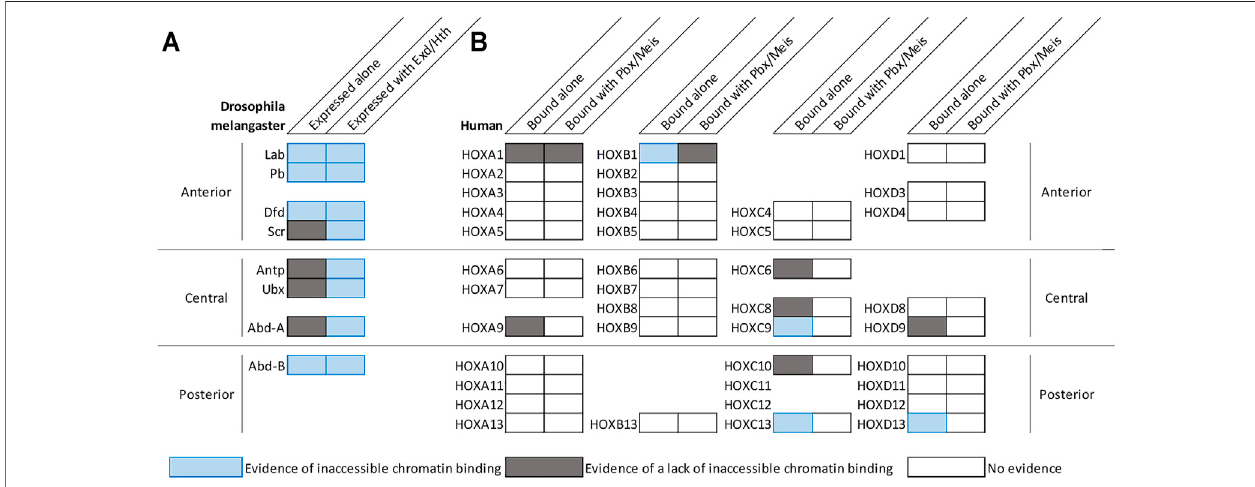
FIGURE 1 | Select Hox factors can bind inaccessible chromatin with and/or without the help of common co-factors. (A) Diagram summarizing the genomic DNA binding activities of Hox TFs in Drosophila Kc167 cells (data from Beh et al., 2016; Porcelli et al., 2019). By comparing the chromatin accessibility pro fi les of cells prior to Hox factor transfection and genome binding pro fi les after Hox factor transient transfection in Kc167 cells, Beh et al. and Porcelli et al. demonstrated that anterior factors andposterior Drosophila factorstendtohavetheabilitytobindinaccessiblechromatin(Behetal.,2016;Porcellietal.,2019).Furthermore,ExdandHthexpression tend to enhance a factor ’ s ability to bind to inaccessible chromatin (Beh et al., 2016; Porcelli et al., 2019). It is important to note that the ability to bind inaccessible chromatin of Abd-B was not enhanced and the ability of Scr was only slightly enhanced by Exd/Hth. (B) Diagram summarizing the genomic DNA binding activities of humanHoxfactorsinmotorneuroncells(Bulaji ć etal.,2020),mouseembryonicstemcells(Singhetal.,2021),andmouselimbbuds(Desanlisetal.,2020).Thegenomic binding and accessibility pro fi les were intersected to assess inaccessible chromatin binding. Nearby PBX and MEIS motifs were used to determine co-binding. Drosophila and human Hox factors follow a similar trend that posterior factors can bind inaccessible chromatin more so than central factors.